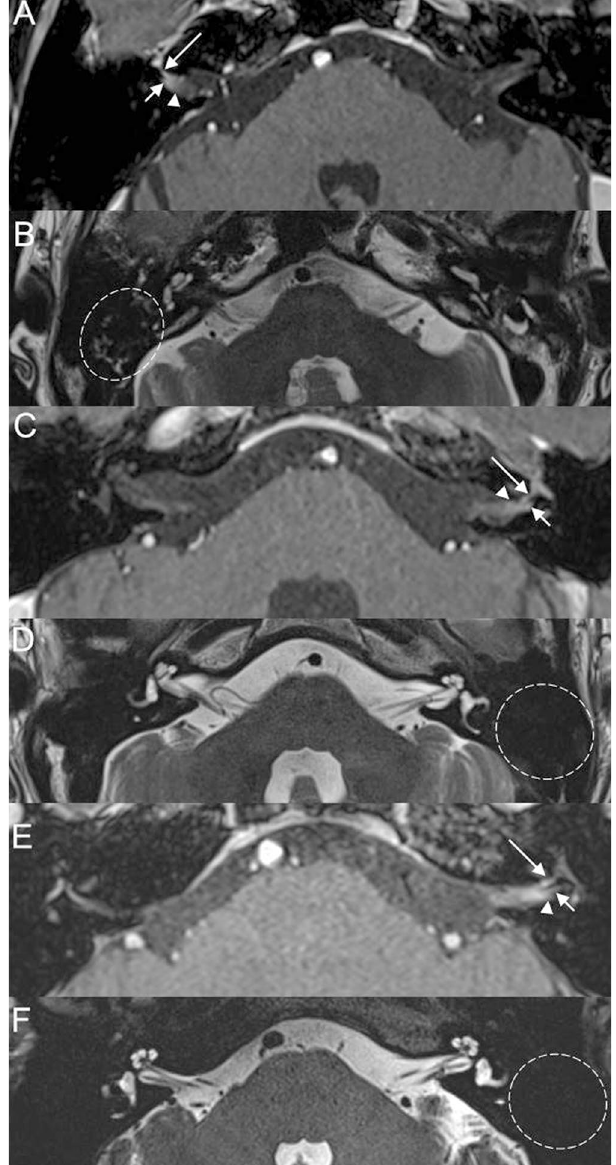
Figure 5. Temporal bone MRI of the patient with zoster sine herpete in the right side ( A , B ). ( A ) Post-contrast 3D T1 weighted image at the level of the internal auditory canal demonstrates enhancement of the labyrinthine segment of the right facial nerve (long arrow), right vestibular nerve (short arrow), and dura (arrowhead). ( B ) Non-contrast axial T2-weighted image shows high signal intensity from the fluid in the right mastoid suggesting mastoid effusion (dotted circle). Temporal bone MRI of the patient, who developed vesicular skin eruption in the left ear without acute facial nerve palsy ( C , D ). ( C ) Post-contrast 3D T1 weighted image at the level of the internal auditory canal demonstrates enhancement of the labyrinthine segment of the left facial nerve (long arrow), left vestibular nerve (short arrow), and dura (arrowhead). ( D ) Non-contrast axial T2-weighted image shows normal mastoid cavity on the left side (dotted circle). Temporal bone MRI of another patient, who developed vesicular skin eruption in the left ear without acute facial nerve palsy ( E , F ). ( E ) Post-contrast 3D T1 weighted image at the level of the internal auditory canal demonstrates enhancement of the labyrinthine segment of the left facial nerve (long arrow), left vestibular nerve (short arrow), and dura (arrowhead). ( D ) Non- contrast axial T2-weighted image shows normal mastoid cavity on the left side (dotted